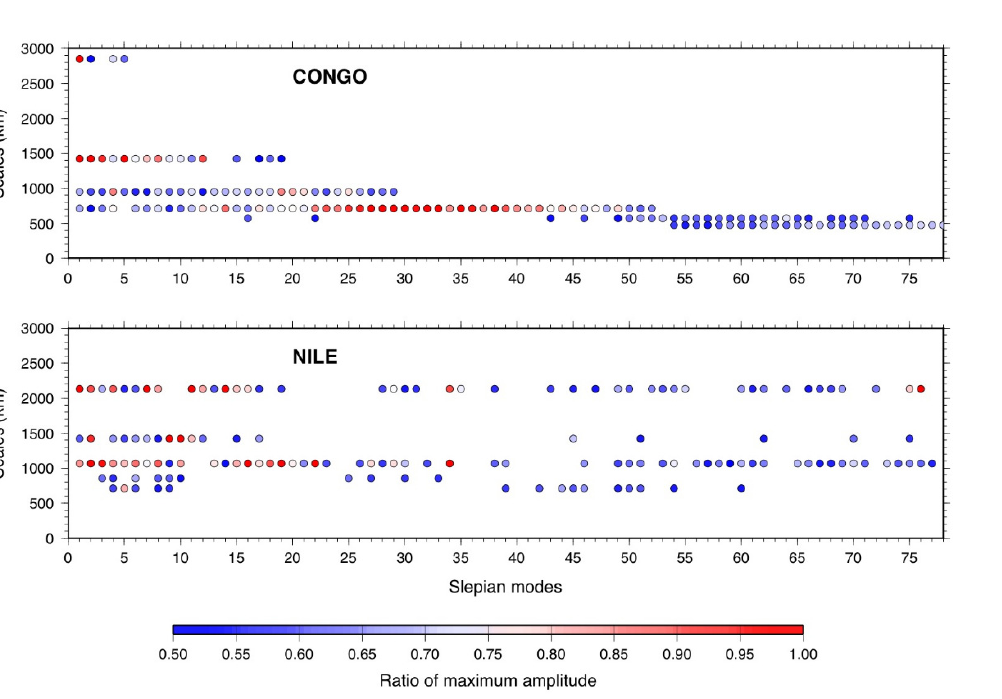
Figure 7. Impact of the combined bandwidths L (30; 60; 90; 120) on the scale analysis of the Congo and Nile watersheds. The amplitude spectrum energies of the 30–60–90 bandwidths have been simply stacked.